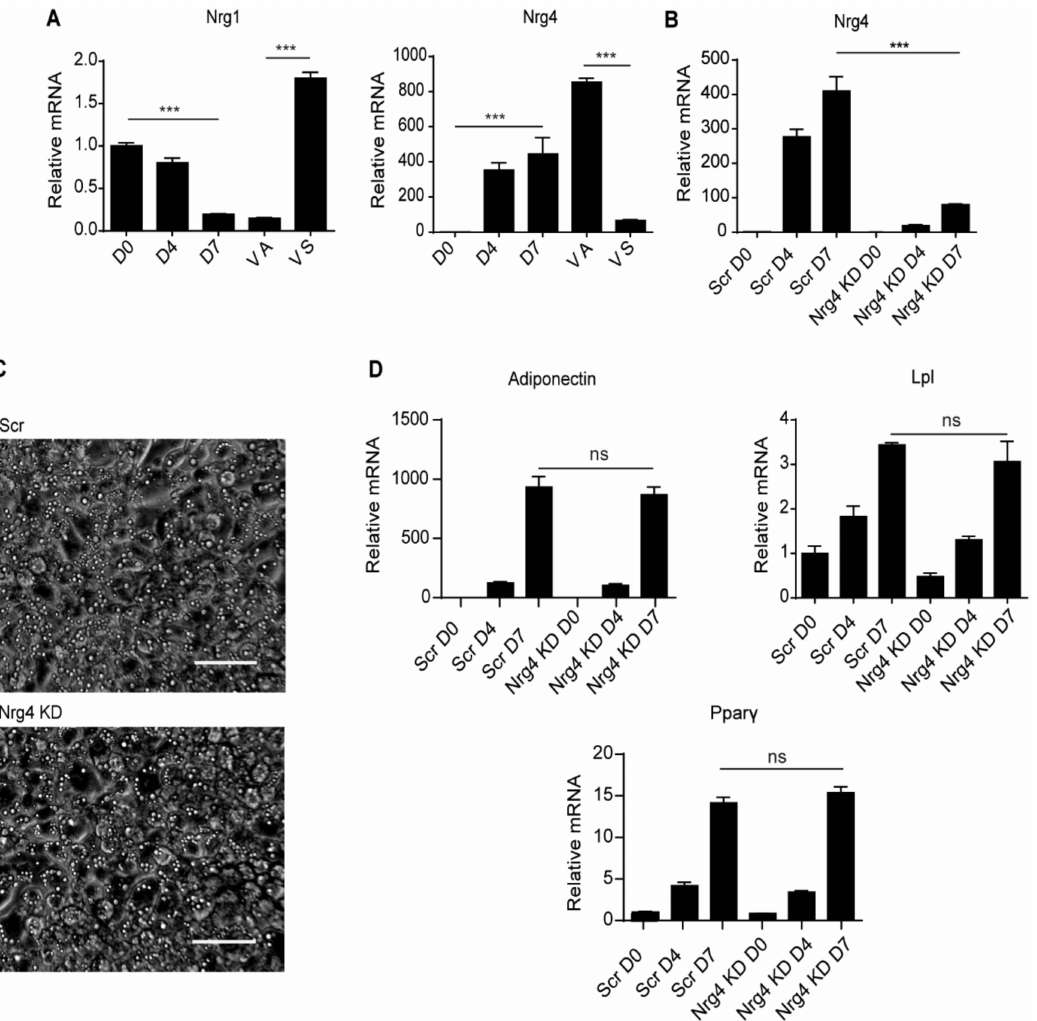
Figure 1. Generation of Nrg4 knockdown 3T3-L1 adipocytes. ( A ) Expression of Nrg1 and Nrg4 in 3T3-L1 pre-adipocytes at day 0 (D0), and at D4 and D7 of differentiation, and in adipocyte (VA) and stromal (VS) fractions from murine visceral white adipose tissue. Data were normalized to D0 3T3-L1 pre-adipocyte expression ( n = 3). ( B ) Expression of Nrg4 in scramble (Scr) and Nrg4 knockdown (KD) cells at D0, D4, and D7 ( n = 6). ( C ) Representative micrographs (20x objective) of the generated Scr and Nrg4 KD adipocytes at D7 of differentiation. Scale bar, 50 µ m. ( D ) Expression of the adipogenic markers Adiponectin, Lipoprotein lipase (Lpl), and Peroxisome proliferator-activated receptor- γ (Ppar γ ) in Scr and Nrg4 KD cells at D0, D4, and D7 ( n = 6). All qPCR data were normalized to Scr D0 pre-adipocyte expression. Data represent mean ± SEM. *** p ≤ 0.001, ns (not